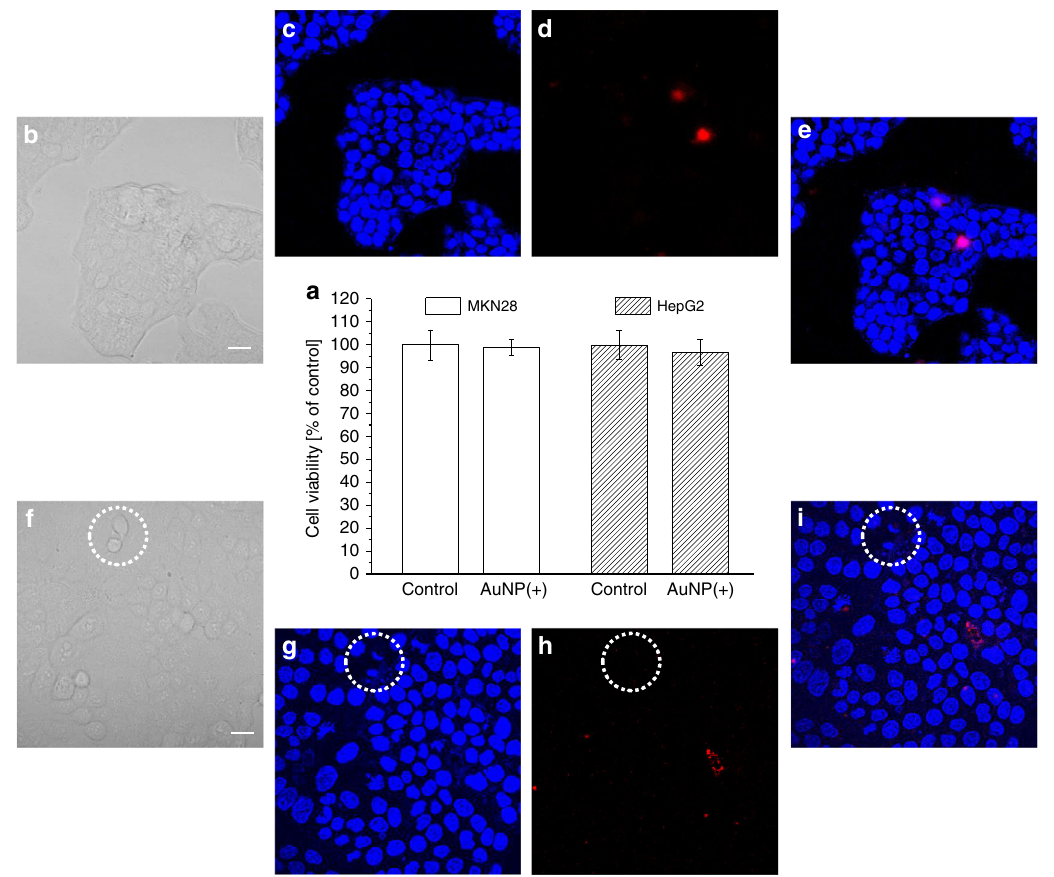
Fig. 4 Cytotoxicity assay after cell surface labelling with pH-sensitive AuNP. a MTT assay results reported as percentage of living cells with respect to the average of the control samples. Both MKN28 and HepG2 labelled with AuNP do not show statistically signi fi cant difference with respect to their controls (two-tailed unpaired t test, p < 0.05, n = 3 independent experiments, error bars show the standard deviation from the mean). b Bright- fi eld, c Hoechst nuclei dye fl uorescence, d PI dye fl uorescence, and e merged fl uorescence images collected from the same location of a control sample of MKN28. Similarly, f – i report the images collected from an AuNP treated MKN28 sample, respectively. The region inside the dotted white circle show the occurrence of nuclei fragmentation during cell mitosis, which represents an additional proof of normal physiological activity of the cells. Scale bars: 20 µ m. Source data are provided as a Source Data fi le. Source dataSource